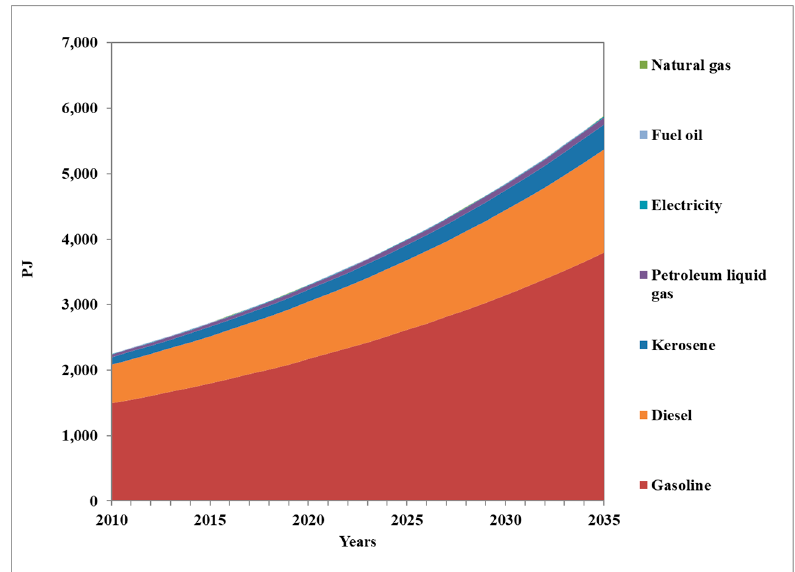
Figure 2. Evolution of the Mexican vehicle fleet in the BLS.